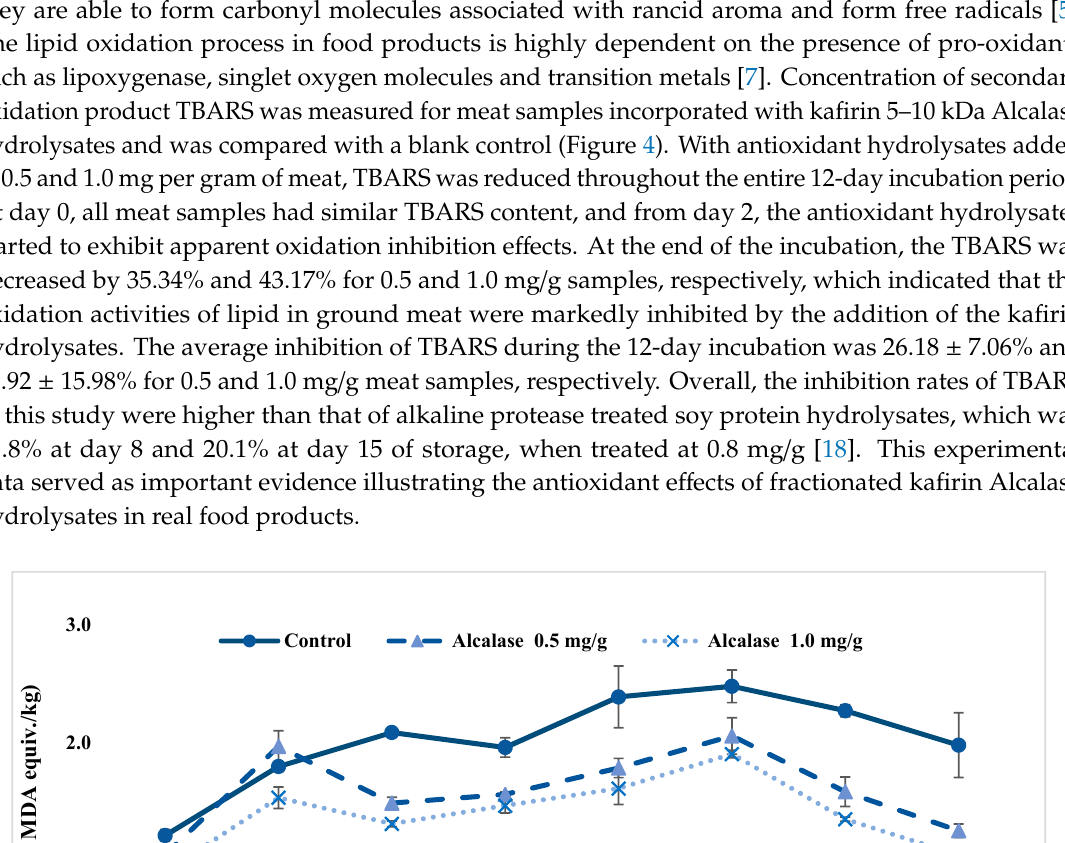
Figure 3 . Inhibition effects of kafirin Alcalase 5–10 kDa hydrolysates prepared at enzyme-to-substrate ratio of 0.4 Au/g and hydrolyzed for 4 hr in an oil-in-water emulsion model system incorporated at 50 and 100 mg/mL oil. ( A ). Emulsion turbidity (Abs at 500 nm) and stability (%); ( B ). POV (mM cumene hydroperoxide equivalent); ( C ). TBARS ( μ M tetramethoxypropan equivalent). Different lowercase and capital letters indicated significant difference at p < 0.05.